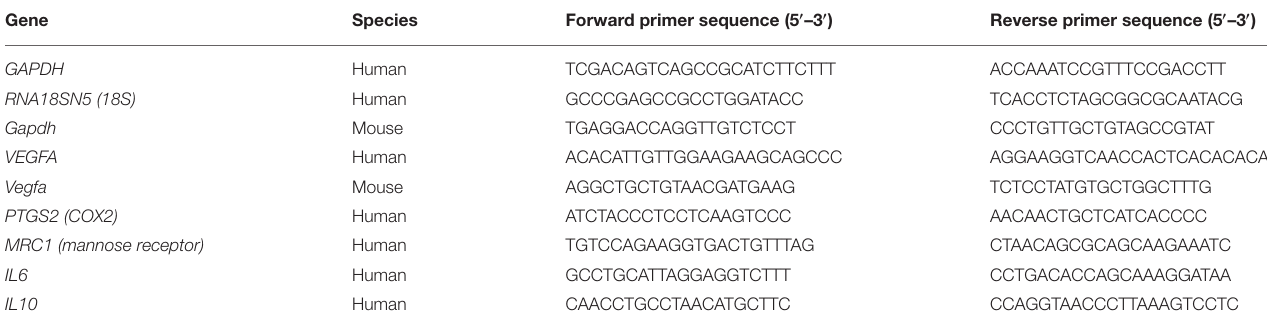
TABLE 1 | PCR primer